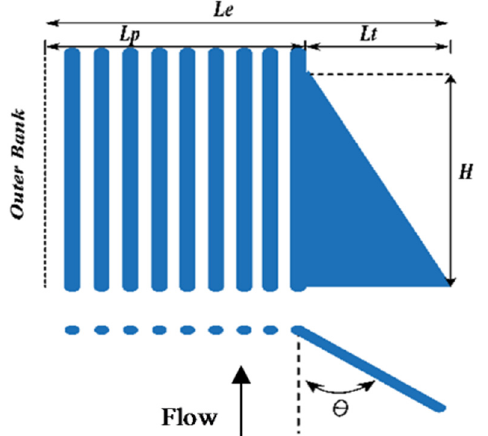
Figure 2. Enhanced permeable groin and its parameters.